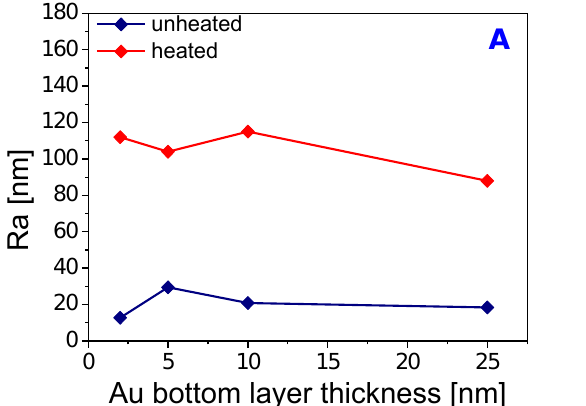
Figure 6. Surface roughness was determined by AFM on 30 × 30 µ m images. Selected PLLA samples with sputtered Au (bottom layer) and Ti (top layer) layers with a total thickness of 30 nm ( A ). Surface roughness was determined by AFM on 30 × 30 µ m images. Selected PLLA samples with sputtered Ti (bottom layer) and Au (top layer) layers with a total thickness of 50 nm ( B